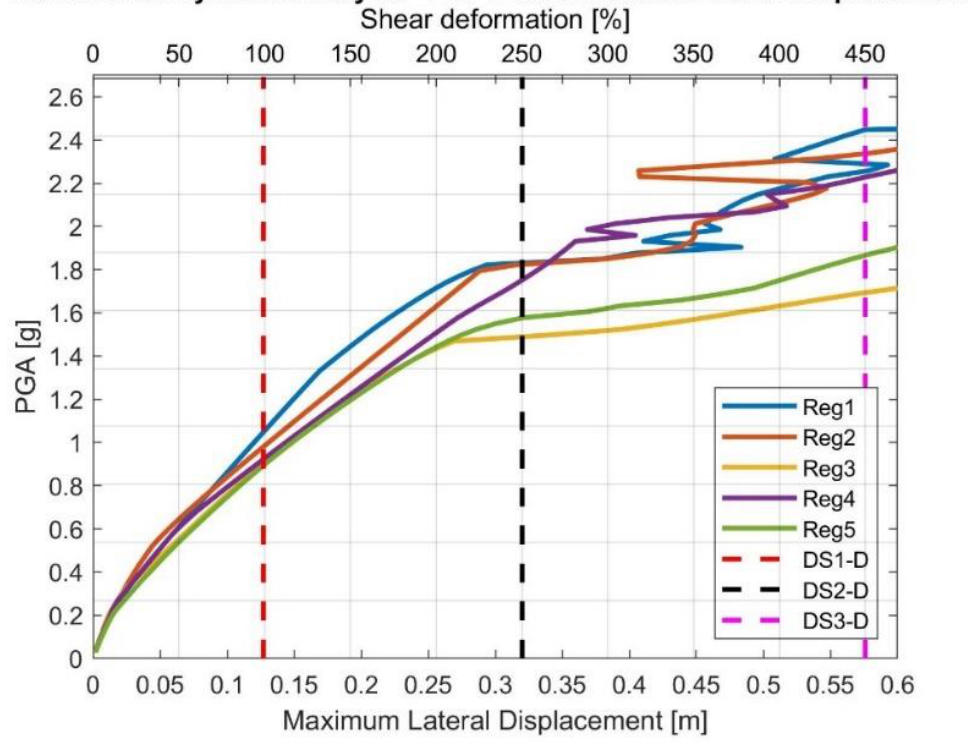
Figure 11. IDA for lateral displacement EDP.